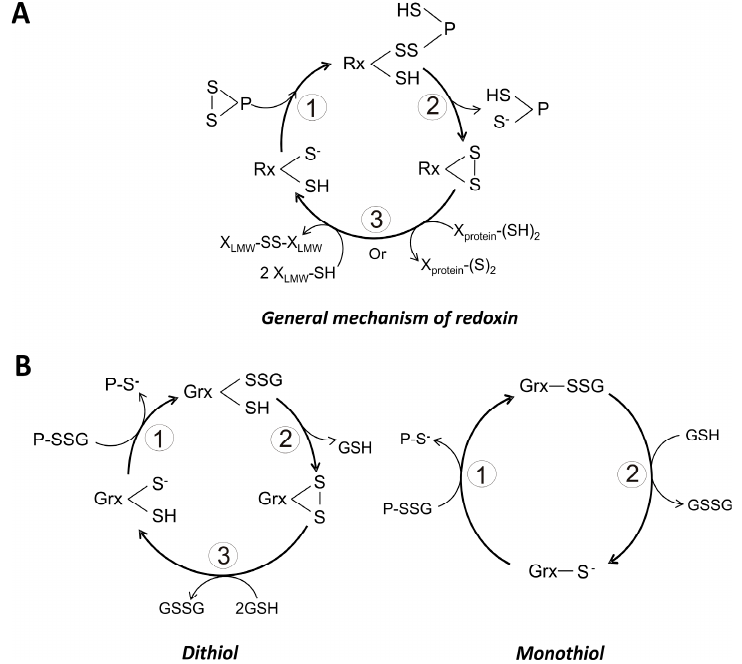
Figure 3 . General catalytic mechanisms for monothiol and dithiol redoxins. ( A ) General catalytic cycle for the reduction of a protein disulfide by a redoxin. The potential electron donor for the redoxin can